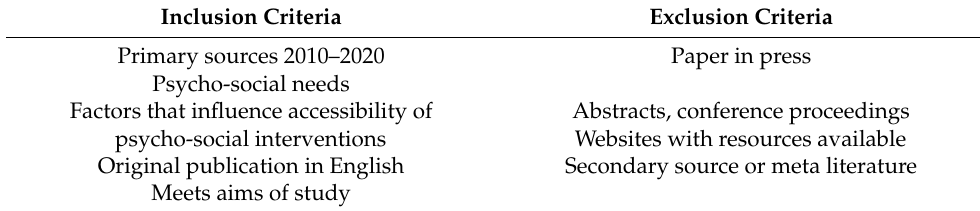
Table 1. Inclusion and exclusion criteria.